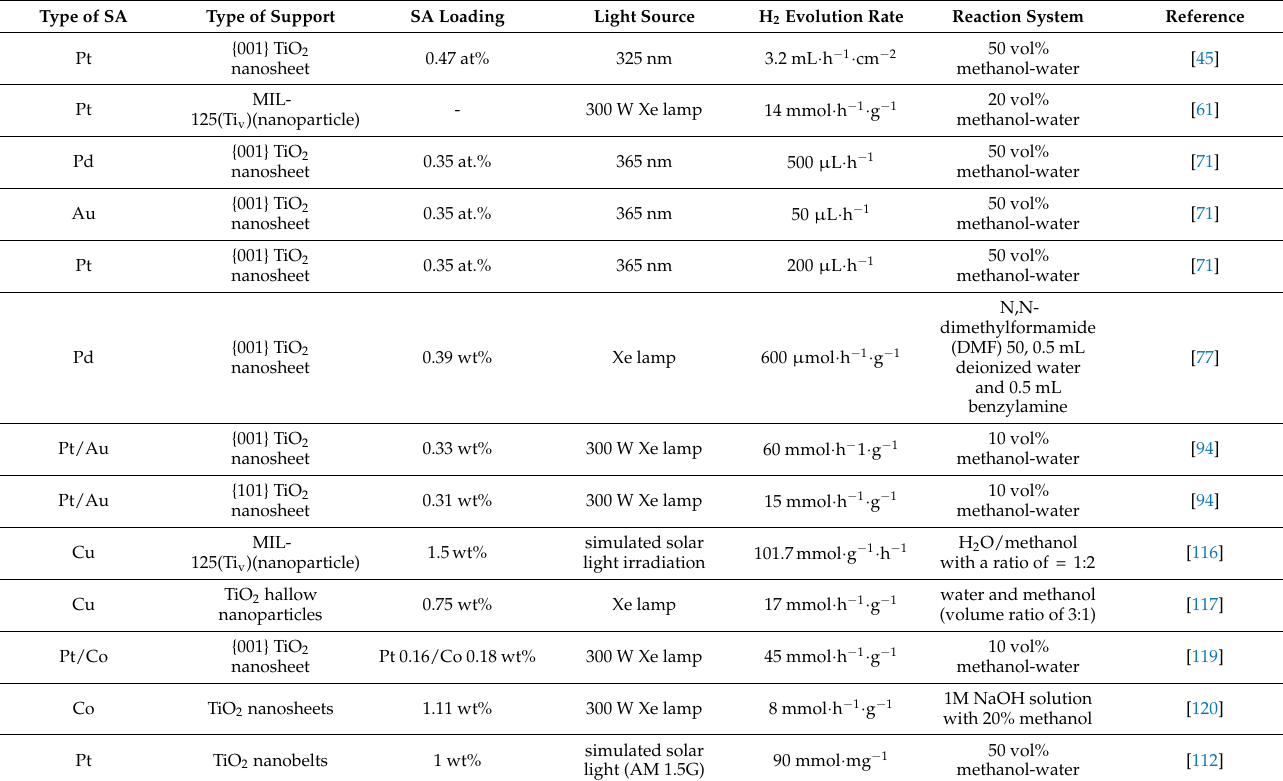
Table 1. Overview of the photocatalytic H 2 evolution rate for SA decorated TiO 2 nanostructures from literature, including the photocatalytic system (SA metal, SA loading, light source, and reactions